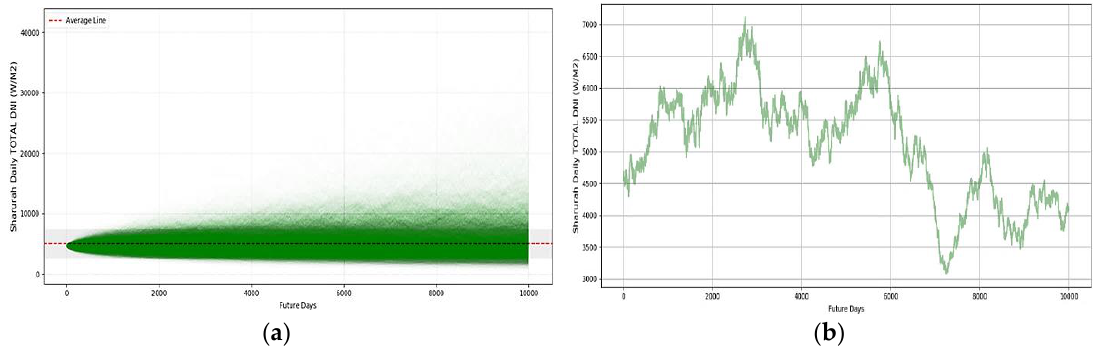
Figure 12. ( a ) Daily total solar DNI distributions for the south region, as predicted by MCS and BM,